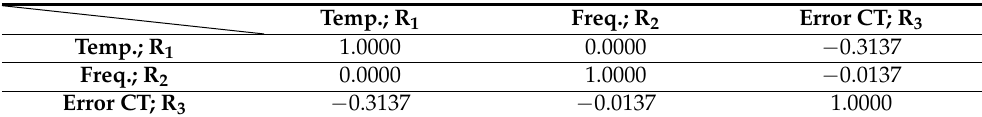
Table 5. Correlation matrix.